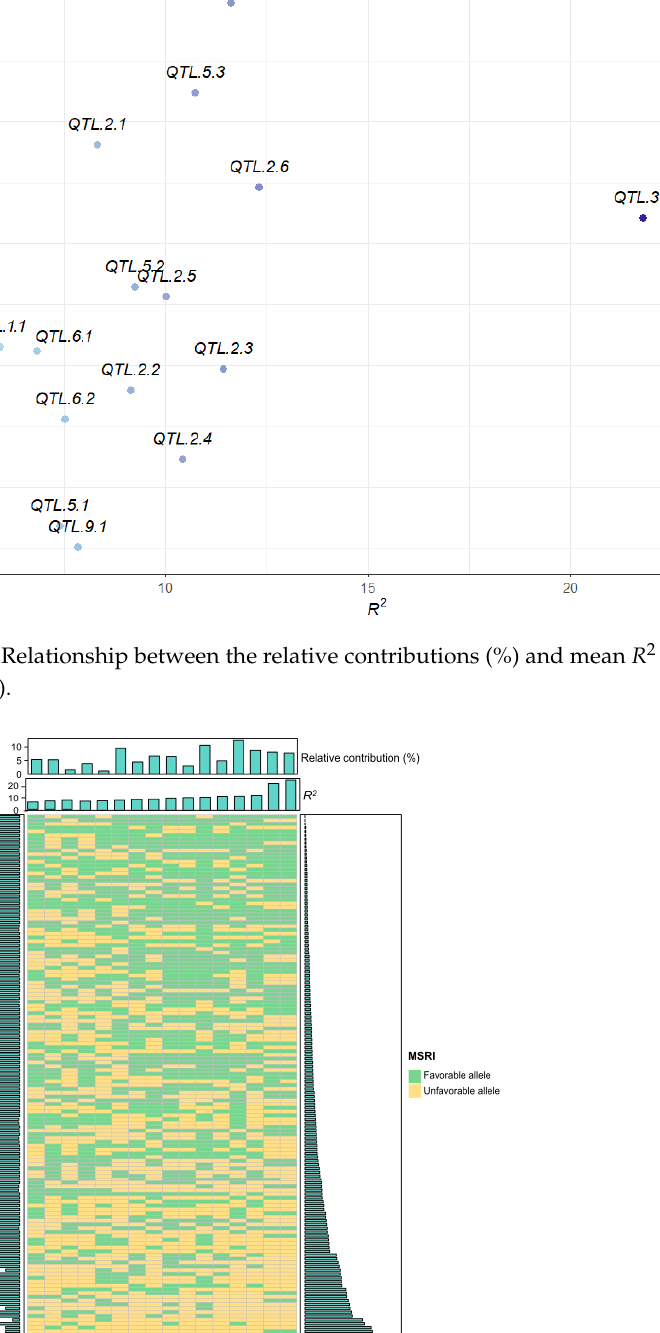
Figure 6. Favorable alleles of 16 quantitative trait loci (QTL) for marsh spot resistance index (MSRI) in the 138 recombinant inbred lines (RILs). The mean dataset over five years and two soil types was used. R 2 refers to phenotypic variation (%) in MSRI explained by a QTL.